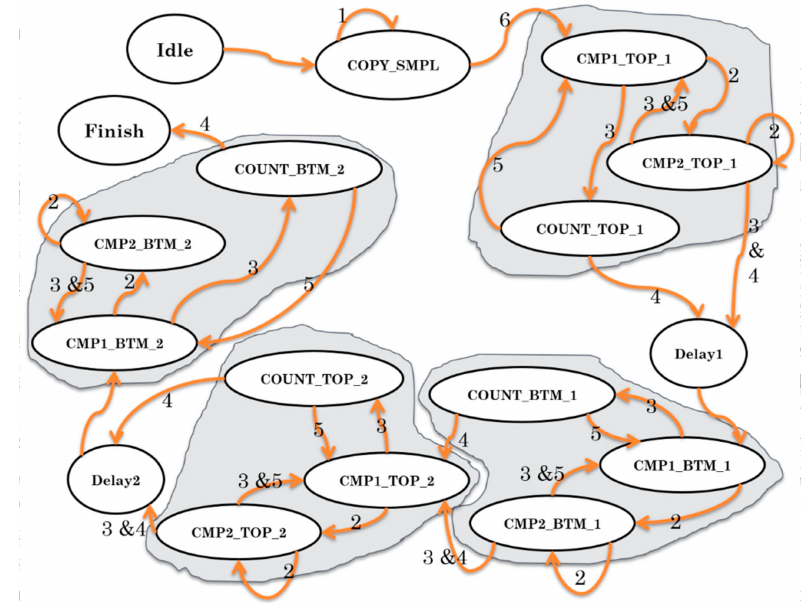
Figure 9. State machine of control logic.